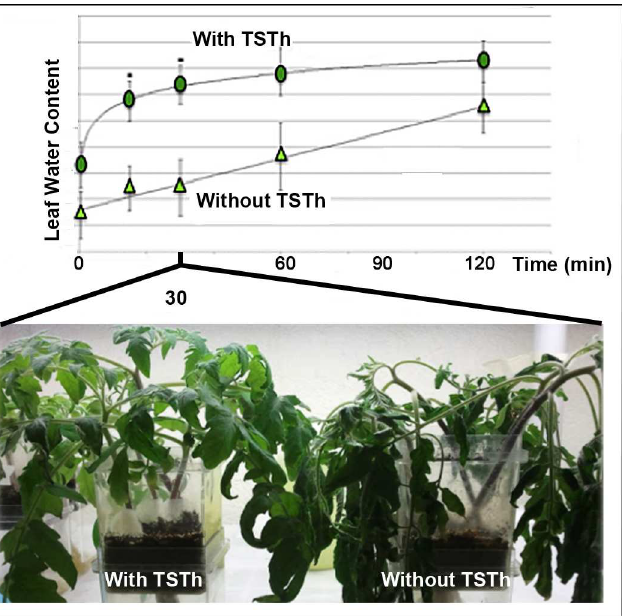
Fig 3. TSTh improved drought recoveryfor tomato seedlings. Six-week-oldtomato seedlings were deprived of water for 2 d to inducewilt, then wateredheavily. The graph shows leaf water content prior to and duringrecovery. Plants colonizedwith TSTh (ovals) wilted less and recovered faster than those without (triangles).The image shows recovery at 30 min. ‘With TSTh’ regression:y = 0.165 ln(x) + 88.9, r 2 = 0.9988. ‘Without TSTh’ regression: y = 0.016 x + 87.79, r 2 =